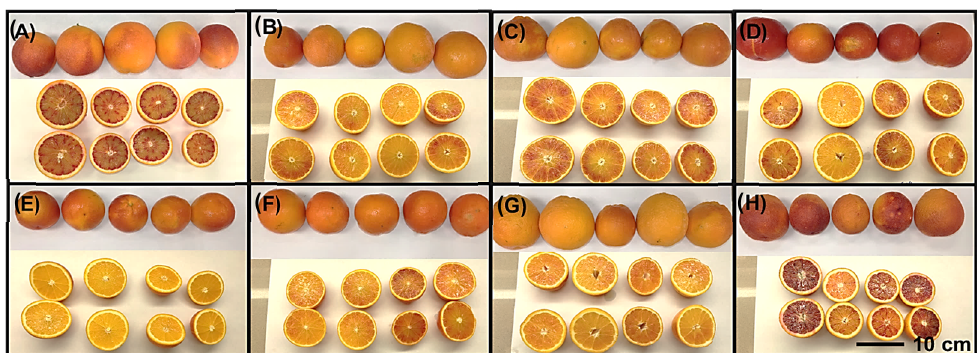
Figure 1. Representative images of the eight blood orange fruits showing the di ff erent morphologi- cal characteristics of Italian varieties (( B )Tarocco Sant(cid:31)Al fi o, ( C ) Tarocco Dalmuso, ( D ) Tarocco Rosso, ( E ) Tarocco Gallo, ( F ) Tarocco Scirè, ( G ) Tarocco Meli and ( H ) Moro) versus Spanish variety (( A ) Sanguinelli). Results corresponding to the morphological and qualitative characterization of the blood oranges varieties in terms of fruit weight, equatorial diameter, fruit length, crust thickness, number of carpels, number of seeds, crust weight, juice weight, pH, TSS, TA and MI (TSS/TA) is shown in Table 1. The average weight for eight blood oranges analyzed during the January of 2023 season range from 178.3 to 350.6 g. Tarocco Gallo and Tarocco Scirè showed signi fi cantly lower fruit weights (183.2 and 178.3 g, respectively), whereas Tarocco Dalmuso (350.6 g), followed by Taroco Meli (326.2 g) and Tarocco Rosso (288.0 g), had a higher mean fruit weight. Fruit equatorial diameters and length oscillated between 70.1 and 69.1 and 86.4 and 88.8 mm, respectively. The crust thickest was in Tarocco Meli and Moro (6.6 and 5.7 mm, respectively), whereas the thinnest was in Tarocco Dalmuso, Tarocco Scirè and Tarocco Sant(cid:31)Al fi o (3.5, 4.1 and 4.9 mm, respectively). Table 1. Morphological and qualitative parameters of eight blood oranges varieties (Sanguinelli, Tarocco Sant(cid:31)Al fi o, Tarocco Dalmuso, Tarocco Rosso, Tarocco Gallo, Tarocco Scirè, Tarocco Meli and Moro) grafted on Citrus macrophylla .